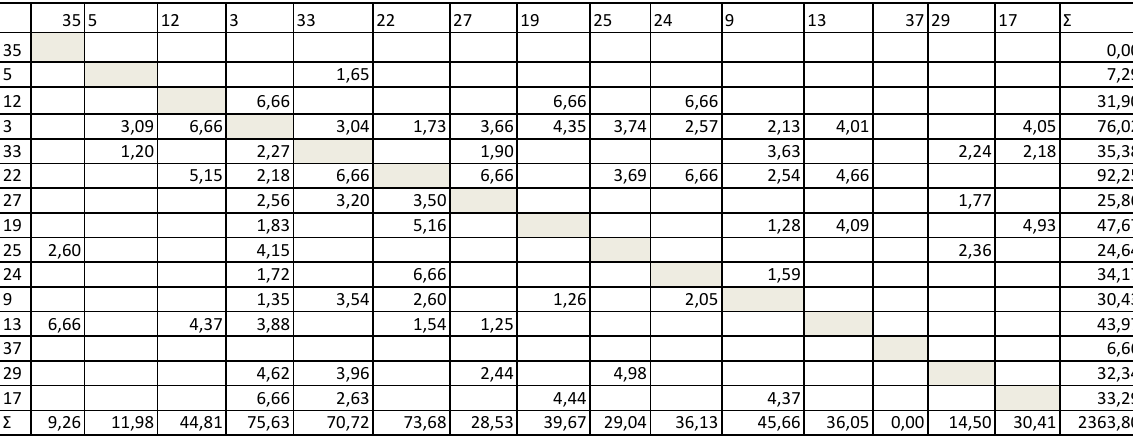
Figure 5: The fragment of the matrix of non-uniformity factors of the rail traflc volumes between the railway stations of a node.